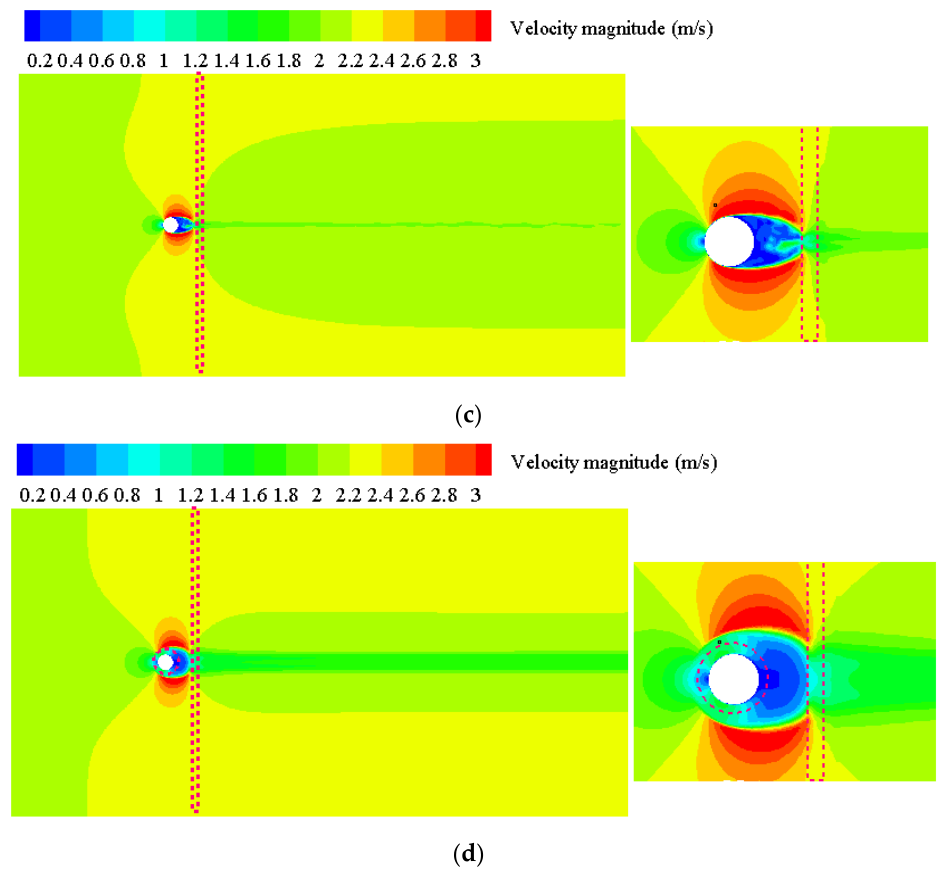
Figure 10. Velocity magnitude contours at Z = 0 plane:( a ) Cylinder; ( b ) PC; ( c ) CP; ( d ) PCP.